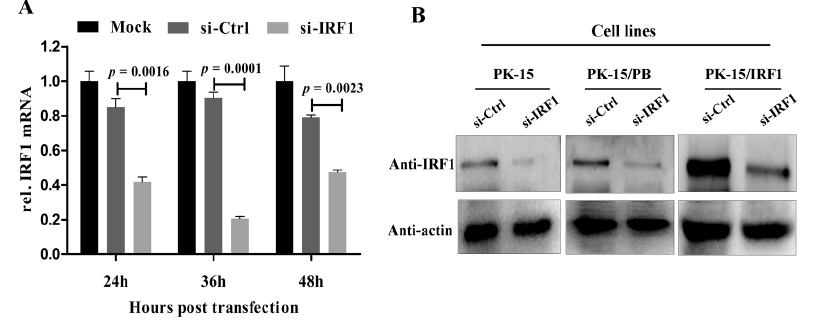
Figure 3. Cont. Figure 3. Cont